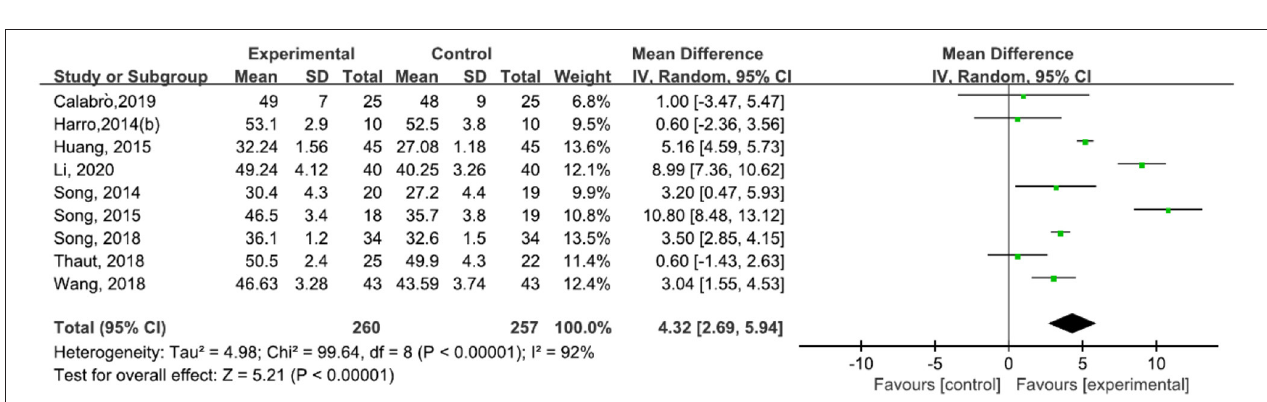
FIGURE 12 | Forest plot showing MD (with 95% CI) for BBS of the included studies comparing the experimental and control groups.